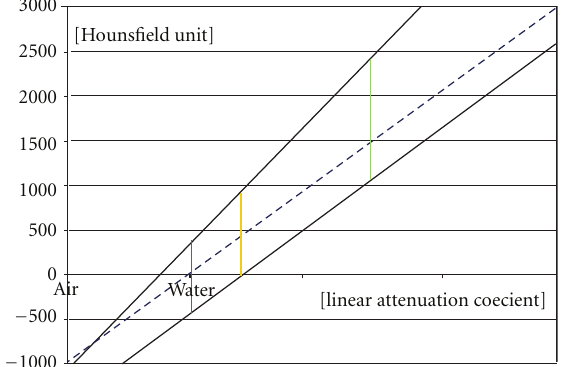
Figure 4: Multiplanar reconstruction (MPR) of the dedicated orbital volume (DV). Axial